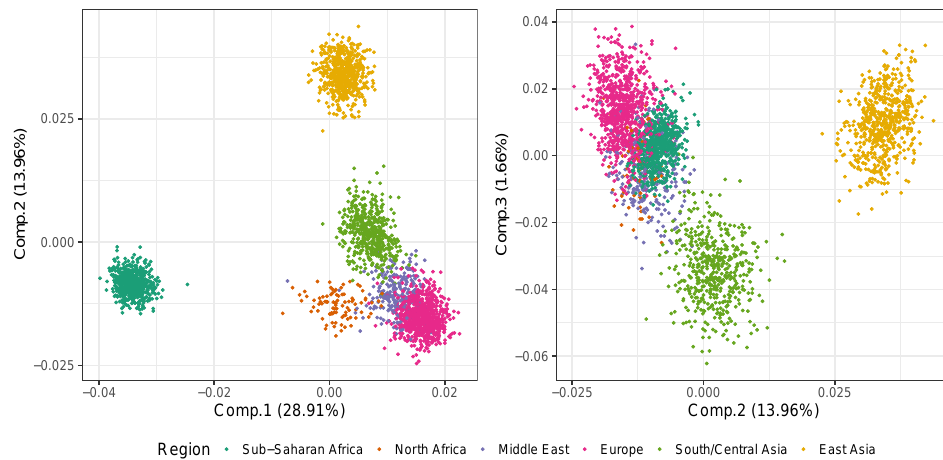
Figure 1. Plot of the first three PCs from the PCA of the reference